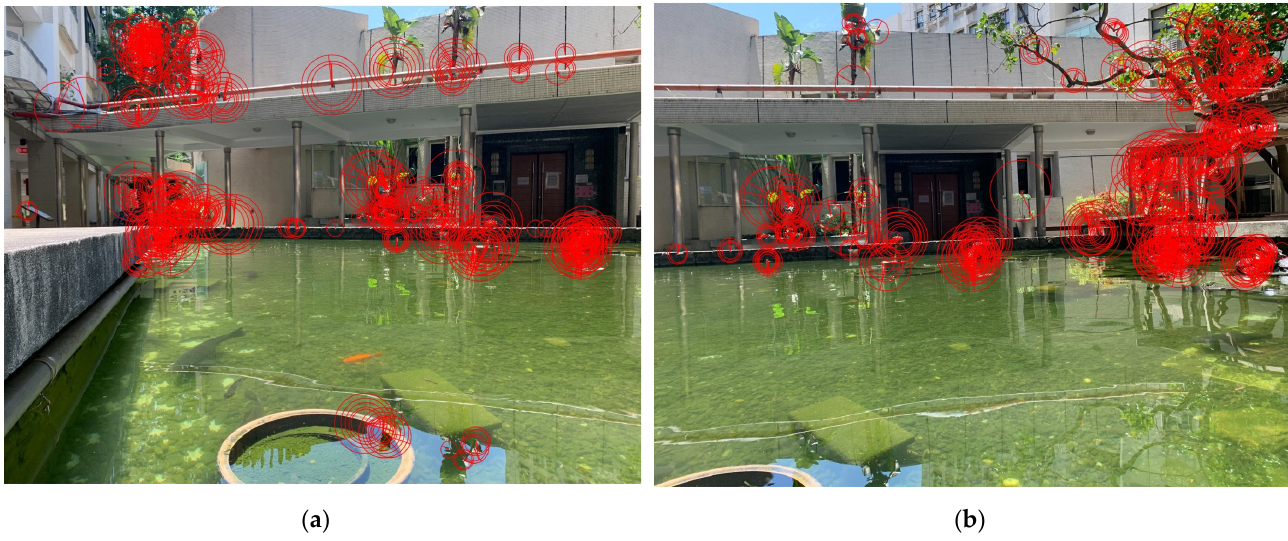
Figure 15. Key points with the descriptors detected as in ( a ) Figure 14a. ( b ) Figure 14b.